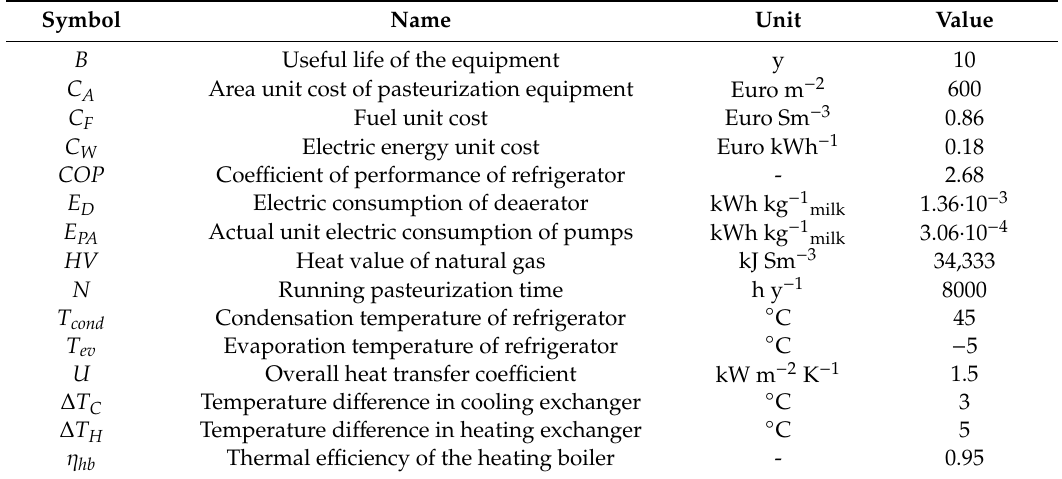
Table 2. List of the data used in the cost-benefit analysis, detected during the survey on the Italian dairies